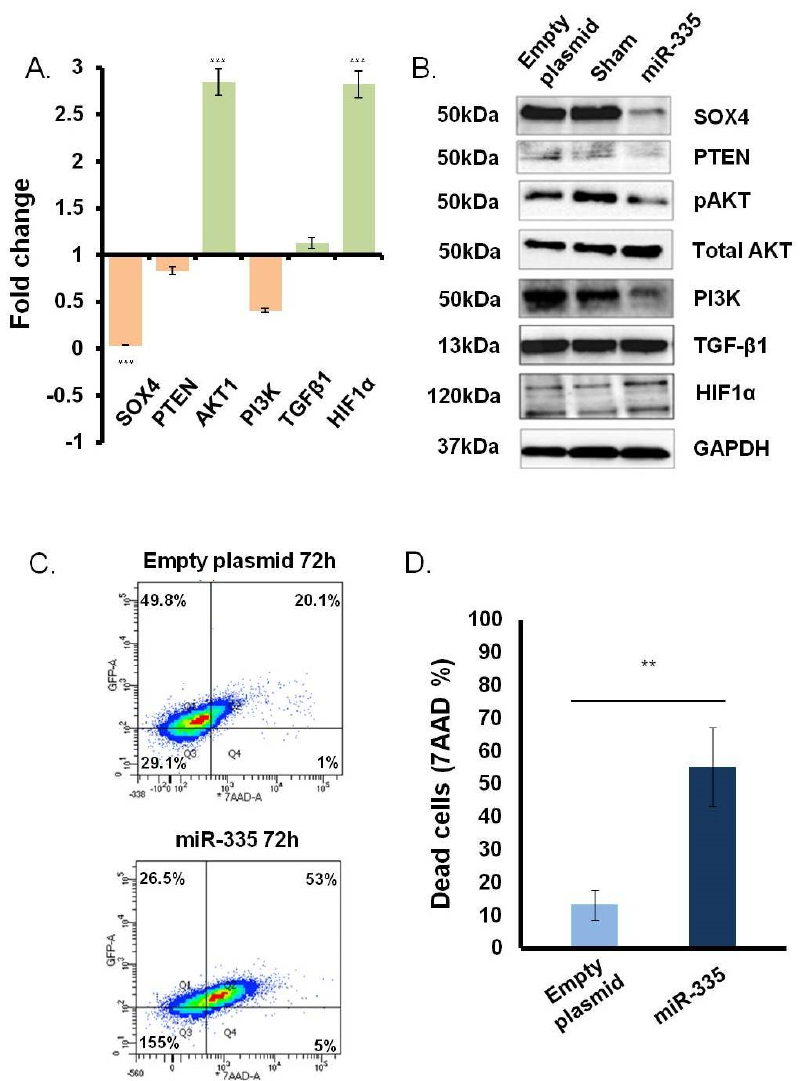
Figure 3. Effect of miR-335 transfection on U266B1 cells. SOX4 and SOX4 downstream genes and gene products were investigated at 72 h. ( A ) RT-qPCR assay. The mRNA modulation (green indicates the up-modulation and orange the down) was generated by normalizing miR-335 gene expression with sham-transfected cells. Statistical analysis was performed between three different control and treated cell values ( p < 0.0005 = *** evaluated by t -test). ( B ) Western blot. Empty plasmid transfected cells, sham-, and miR-335-transfected cells were tested for SOX4 , AKT/pAKT (Ser473), PI3K, PTEN, TGF- β , and HIF1- α . ( C ) Example of flow cytometry 7AAD analysis of U266B1 cells treated as indicated in panel B. ( D ) Cell mortality (7AAD positivity) served in miR-335- vs. empty plasmid-transfected cells. Values were normalized with sham-transfected cells. Data are representative of three independent experiments. ( p < 0.005 = ** evaluated by t -test).